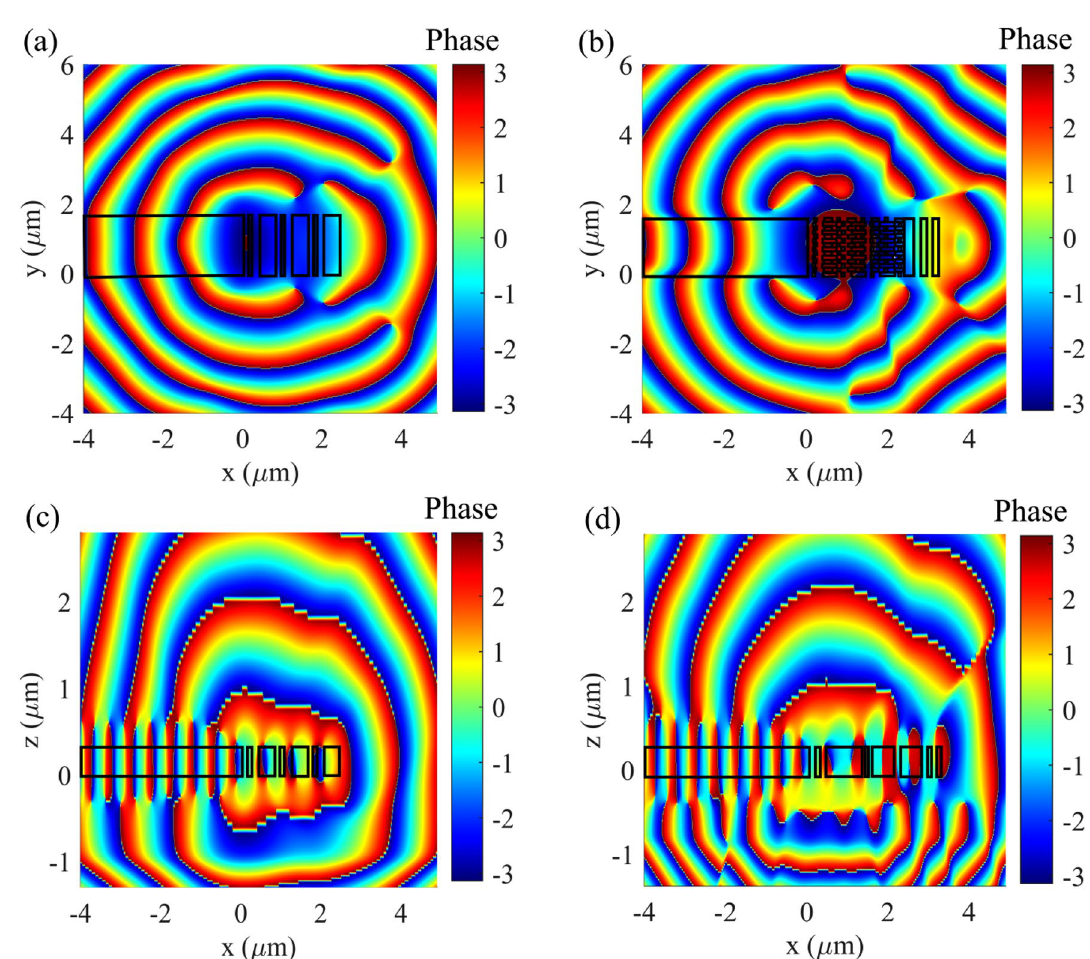
Figure 5. Near-field phases of the electric field on the x–y plane positioned 0.7 μm above the antenna for ( a ) the reference periodic grating and ( b ) the transversally-interleaved chirped antenna at the wavelength of 1550 nm. ( c ) and ( d ) are the phase profiles for the reference periodic grating and the transversally-interleaved chirped antenna, respectively, along the x–z cross-section positioned at the center of the transversally- interleaved chirped antenna as in Fig.